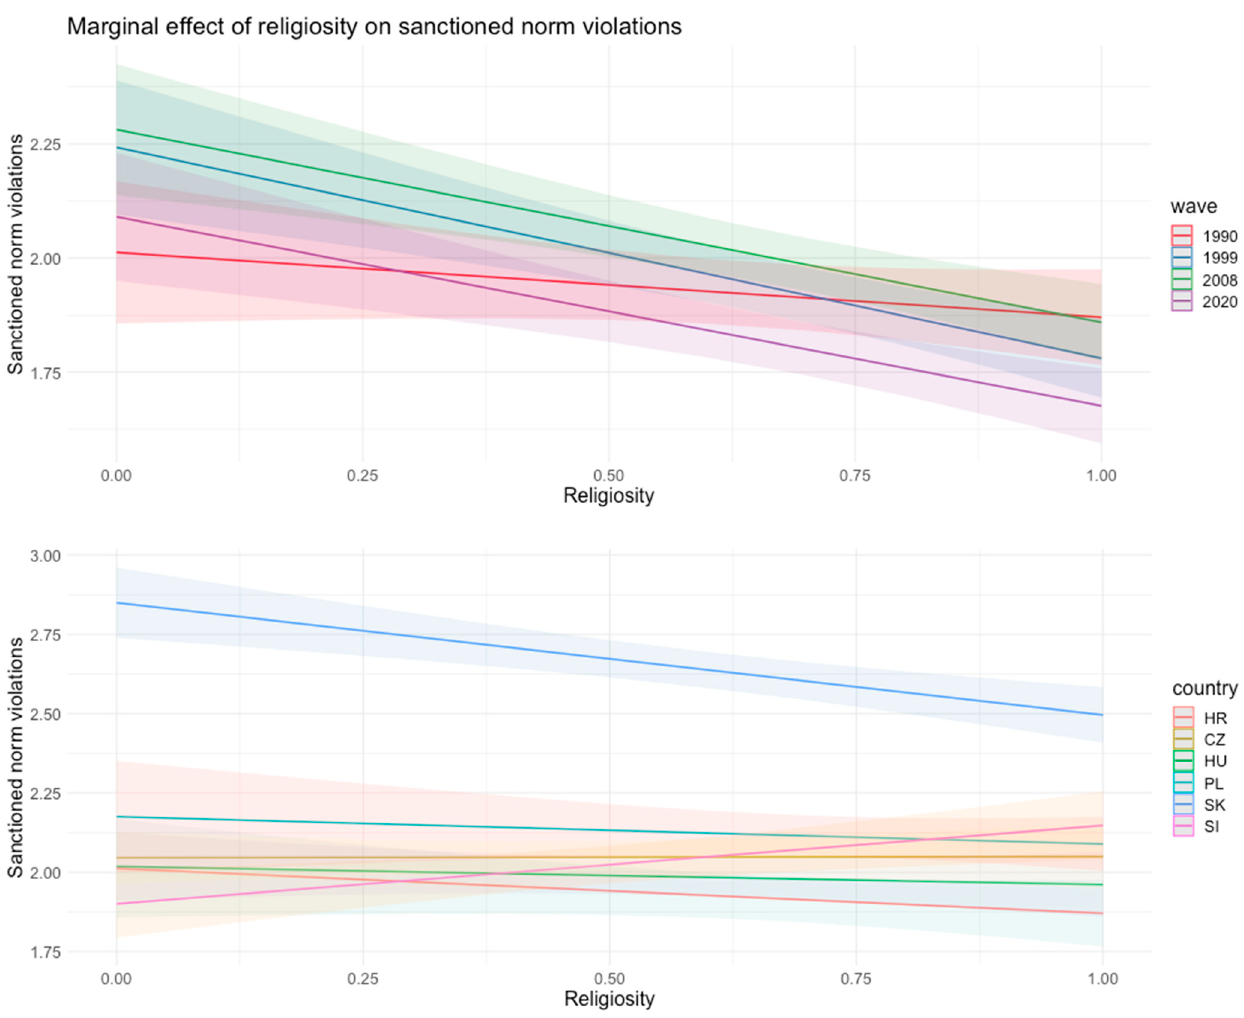
Figure 1. Predicted marginal means of sanctioned norm vilations per waves and countries on different level of religiosity. A more detailed regression table with the interaction effects is available in the Supplementary Materials.